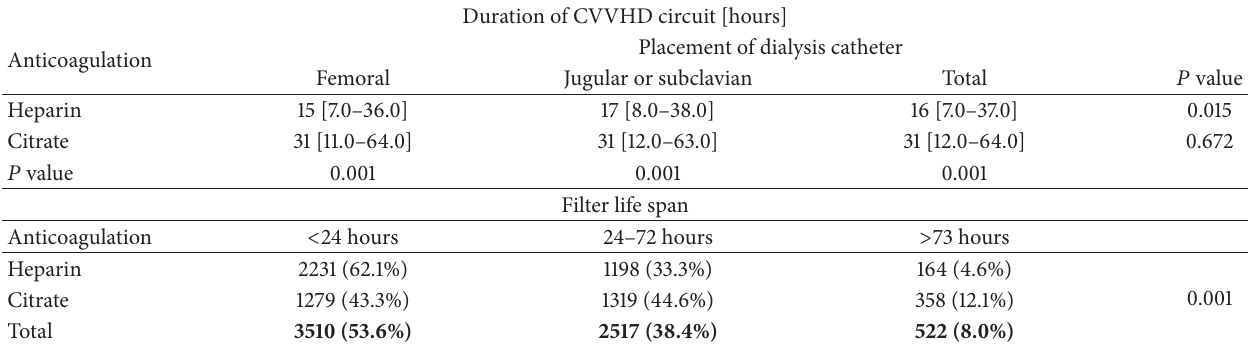
Table 5: Duration of hemodialysis circuit and filter life span in relation to anticoagulation strategy.